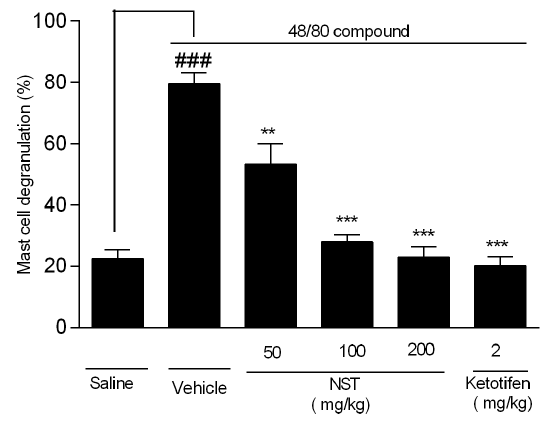
Figure 4 - Effect of the NST (50, 100 and 200 mg/kg, i.p.), vehicle (NaCl 0.9% + 5% Tween 80), and cetotiphen (2 mg/kg i.p.) on ex vivo compound 48/80-induced mast cell degranulation in rats. The values are presented as mean ± SEM. ** p <0.01 and *** p <0.001 when compared with vehicle group. One way ANOVA and Tukey’s post-hoc